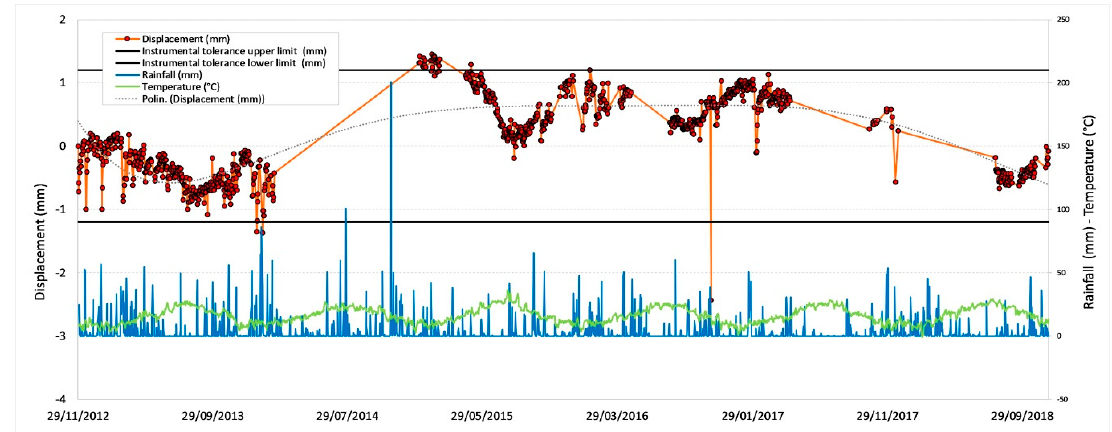
Figure 11. Displacement recorded by the RTS at the measurement point G02 compared to daily average rainfall and temperature. The black lines indicate the instrumental tolerance threshold values.